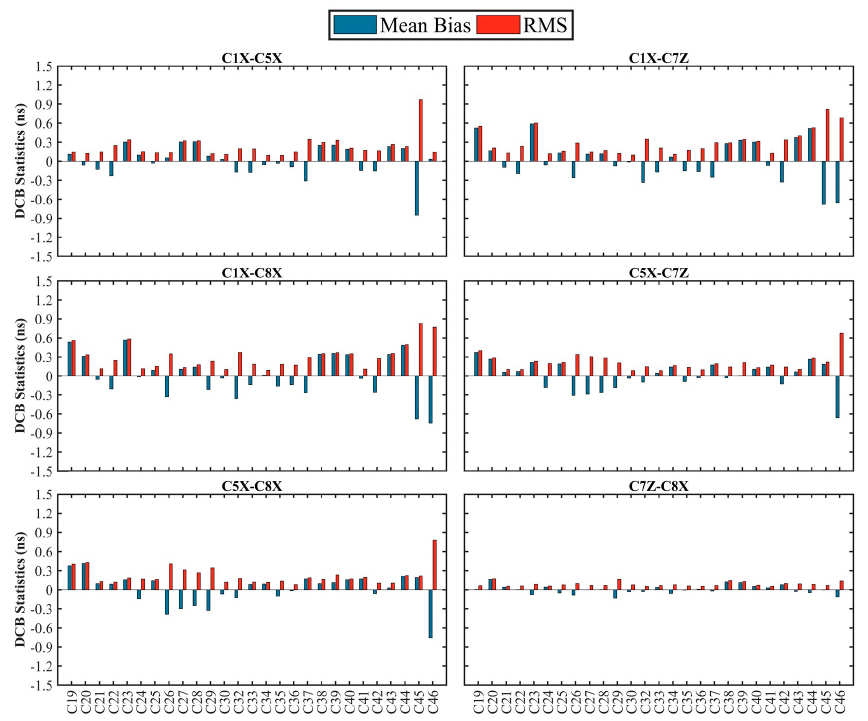
Figure 4. The mean bias and RMS of our estimated C1X-C5X, C1X-C7Z, C1X-C8X, C5X-C7Z, C5X-C8X, and C7Z-C8X, of BDS-3 satellite DCBs, with respect to the conversion values provided by DLR products.